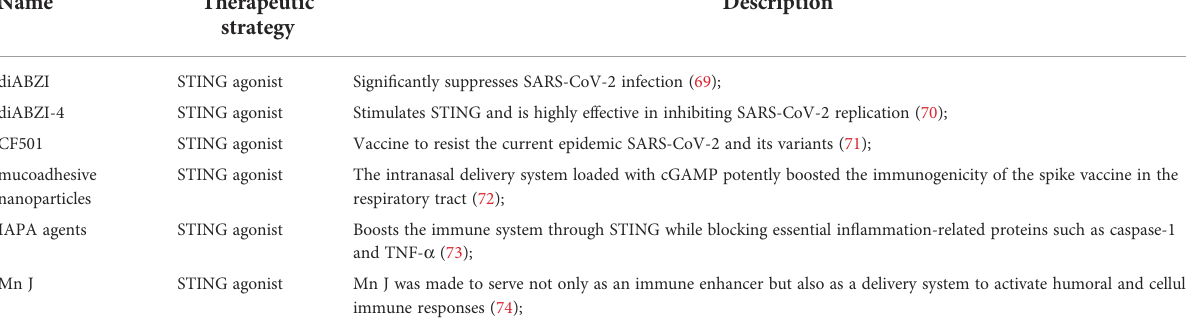
TABLE 1 Potential therapeutic strategy for targeting STING in